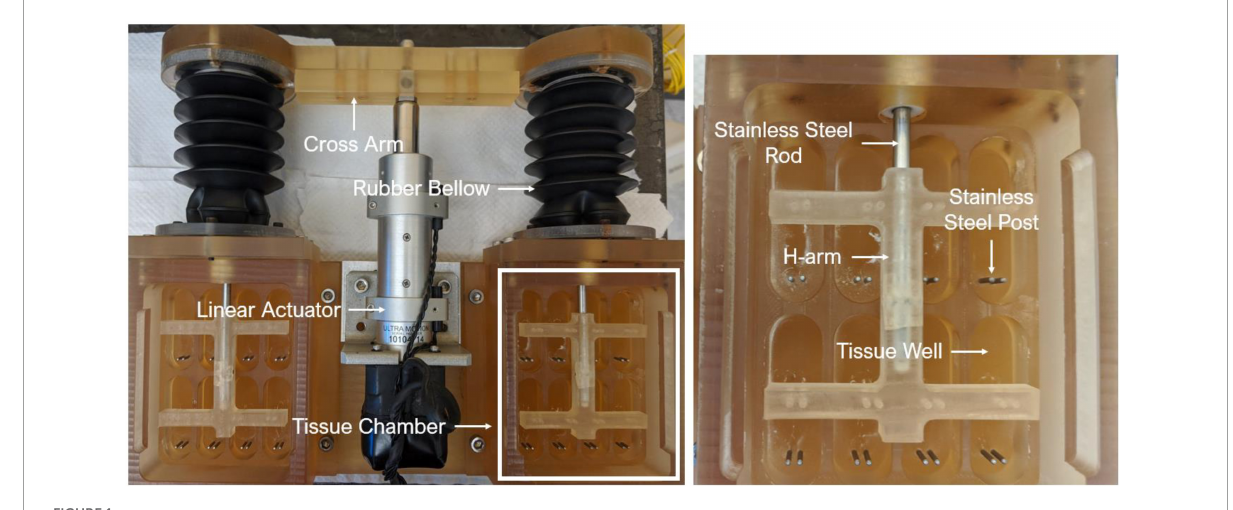
FIGURE1 Ex vivo cyclic stretch